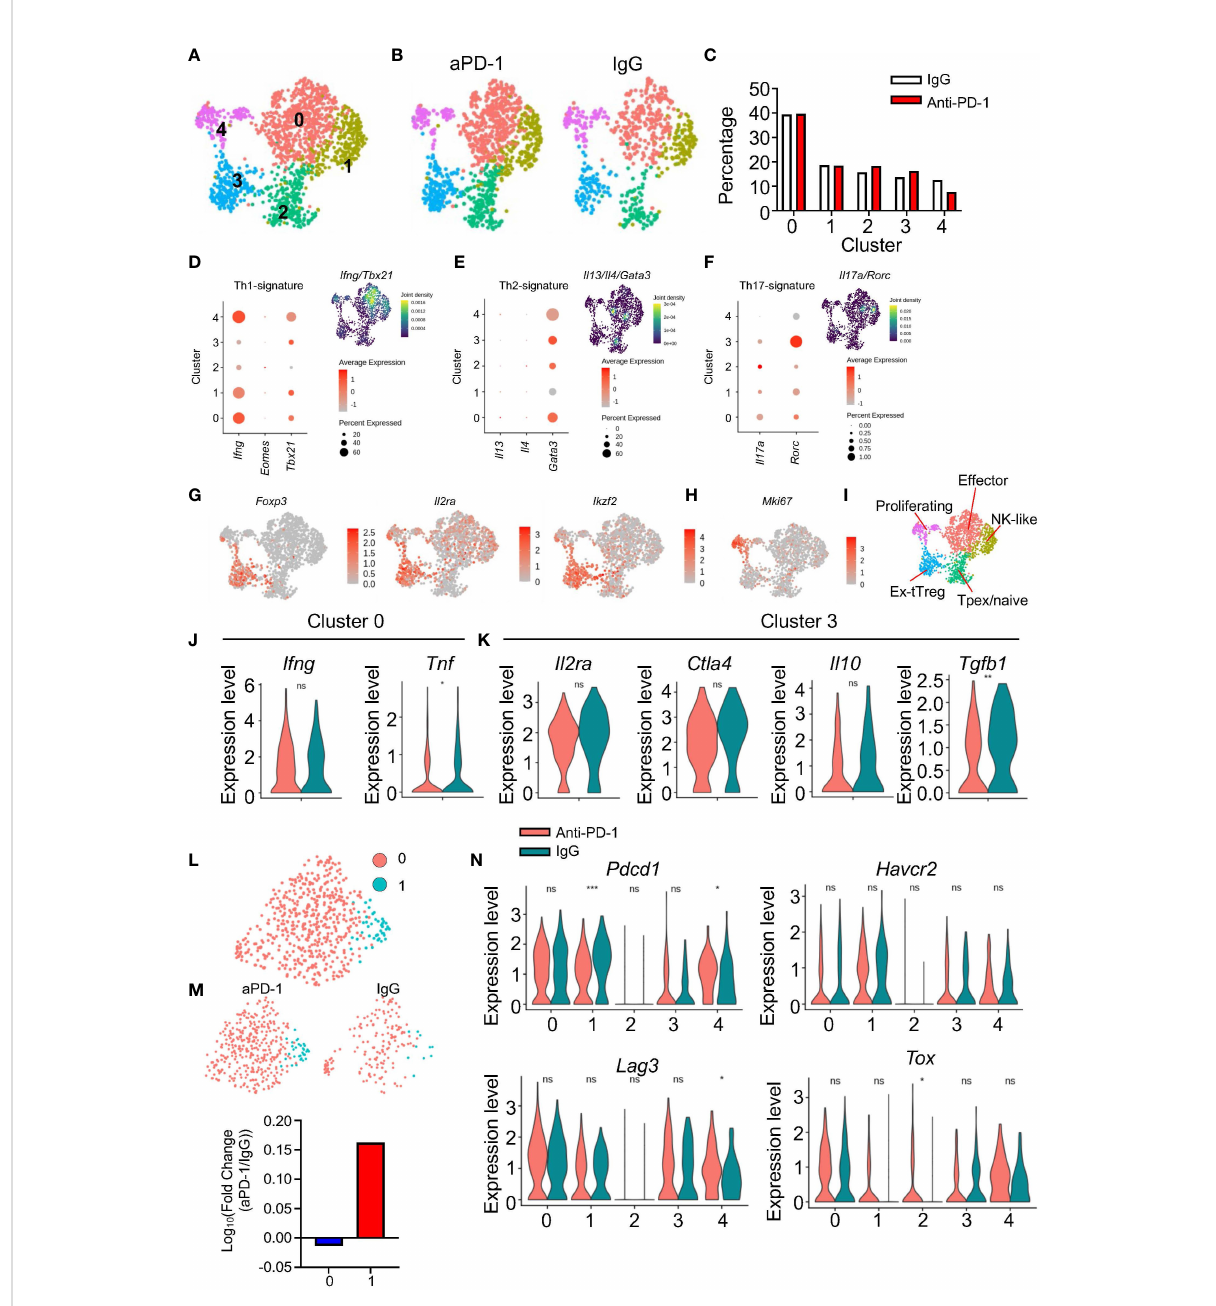
FIGURE 4 Immunological features of CD4 T cells after aPD-1 treatment. (A) CD4 T cells ( Cd3e + Cd4 + Cd8a − doublet − ) were re-clustered. CD4 T-cell clusters are shown by UMAP. (B, C) Changes in clusters of CD4 T cells between IgG and aPD-1 groups are shown by DimPlot (B) and bar graph (C) . (D – F) Th1 signature genes ( Ifng, Eomes, Tbx21 ) (D) , Th2 signature genes ( Il13, Il4, Gata3 ) (E) , and Th17 signature genes ( Il17a, Rorc ) (F) were analyzed. (G, H) Expression of Foxp3, Il2ra, Ikzf2 (G) , and Mki67 (H) from each cluster is shown by FeaturePlot. (I) Characteristics of clusters of CD4 T cells were designated. (J) Gene expression of Ifng and Tnf in cluster 0 is shown. (K) Gene expression of Il2ra , Ctla4 , Il10 , and Tgfb1 in cluster 3 was analyzed. (L, M) Tregs were sub-clustered. (L) Two clusters were identi fi ed. (M) Differences of clusters in Tregs between IgG and aPD-1 groups are shown. (N) Expression of Pdcd1, Havcr2, Lag3 , and Tox in each cluster was analyzed. Data in (J , K, N) were analyzed by the stat_compare_means function with unpaired t-test * P <0.05, ** P <0.01, *** P <0.001. ns, not signi fi